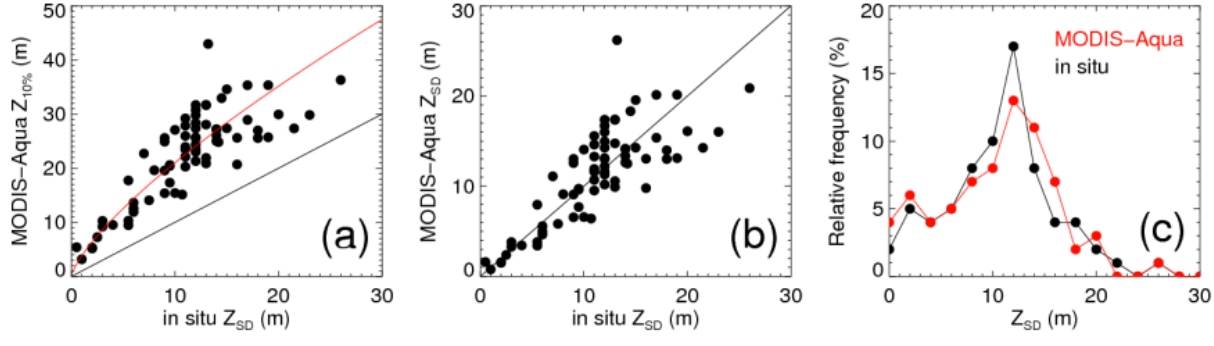
Figure 2. MODIS-Aqua GBR satellite-to- in situ matchups using the GBR-validated algorithm. Panel ( a ) shows in situ Z (Equation (1)) shown in red. Panels ( b ) and ( c ) compare in situ Z from the GBR-validated algorithm. A Type II linear regression analysis of the results presented in (b) yields N = 71, r 2 = 0.63, RMSE = 3.45 and slope = 1.03, and intercept